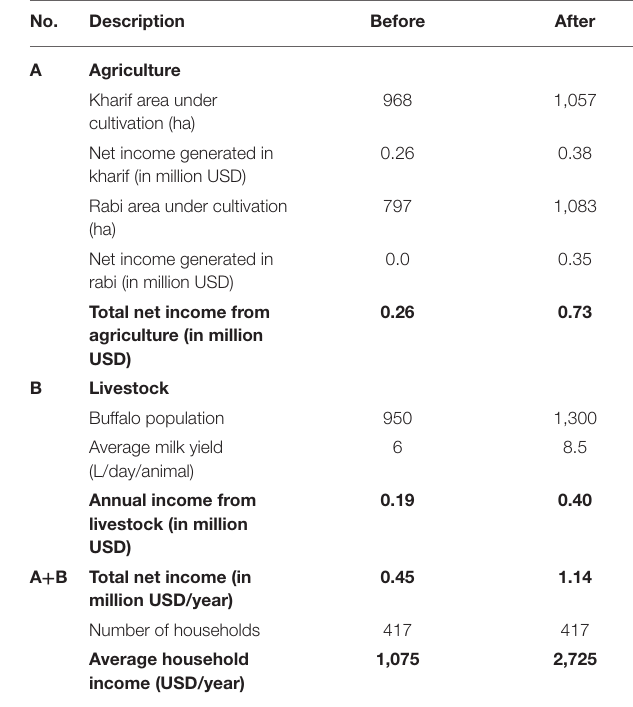
TABLE 3 | Project impact on average household income before and after interventions.